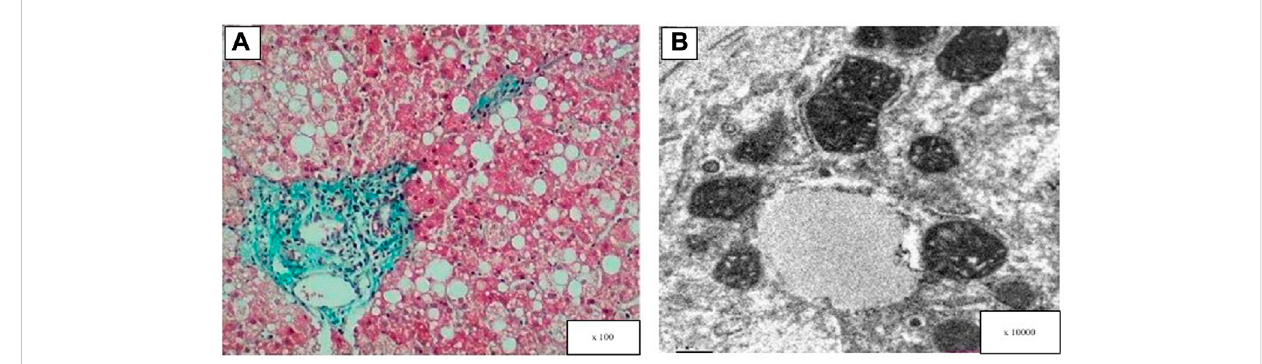
FIGURE 1 Light and electron microscopy analysis of the patient ’ s liver (patient 6). (A) Masson ’ s trichrome stain showed hepatic fi brotic lesions, diffuse hepatocellular steatosis (the size of the bubble fat gets mixed, 70%), and a few hepatocytes showed balloon-like. (B) Electron microscopy: hepatocyte swelling and variable lipid droplets are seen in diffuse